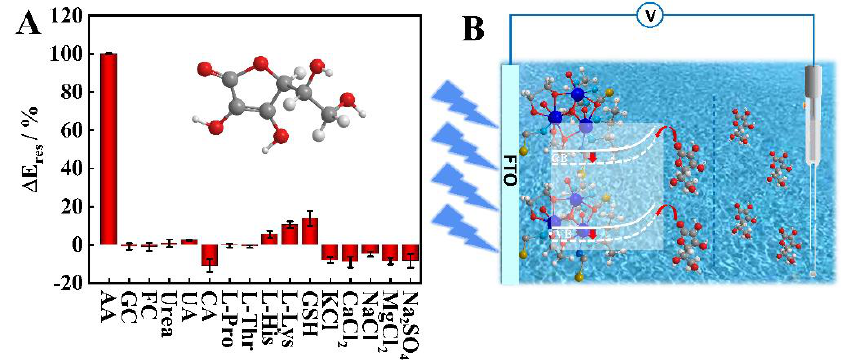
Figure 4. ( A ) Potential responses of the Dy − OSCN/FTO electrode at different concentrations of AA in the range of 7.94 μM to 13.71 mM; ( B ) the corresponding linear calibration curve for AA detection.